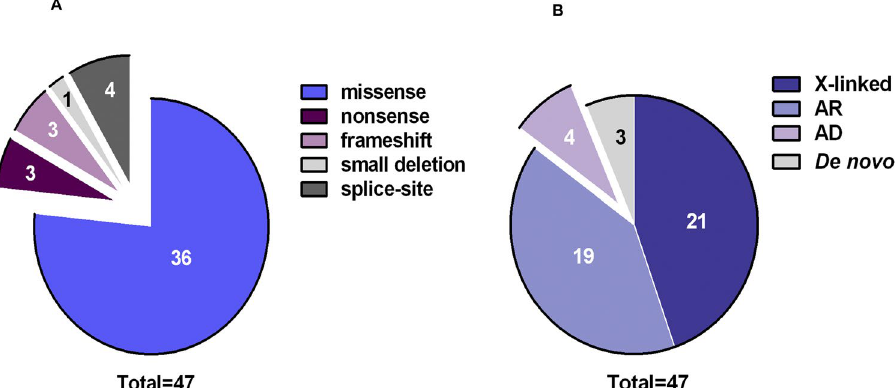
Figure 2. Effect and mode of transmission of the validated variants. Pie charts illustrating the distribution of the confirmed variants found in all probands according to their effect ( A ) or mode of transmission ( B ). AR: autosomal recessive. AD: autosomal